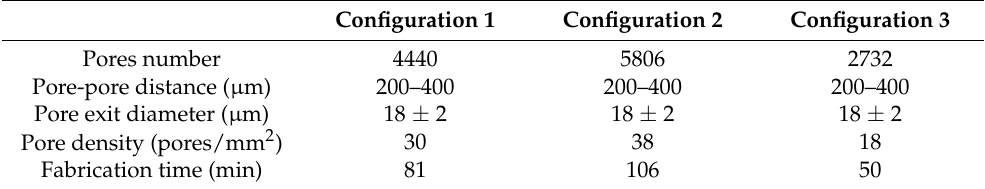
Table 3. Characteristics of CA membrane configurations. The values are referred to the bottom surface of the membranes.